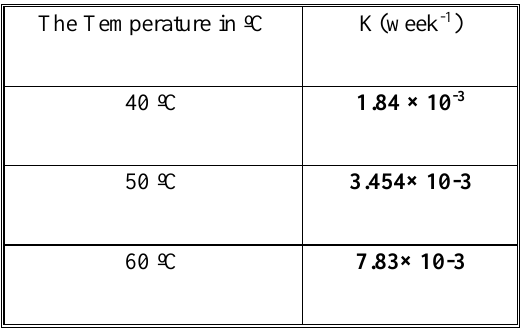
Table 3.The degradation constant of the selected formula f13 lyophilized powder